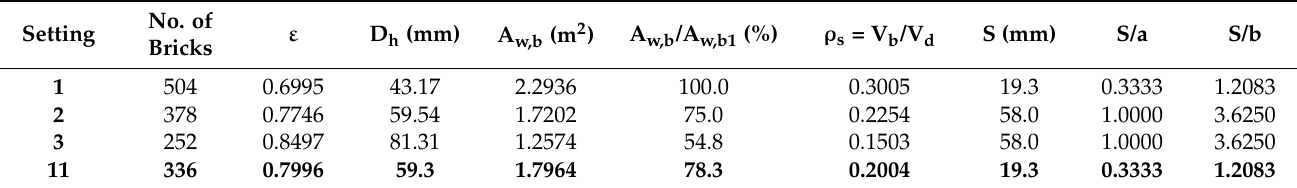
Table 1. Features of the current settings